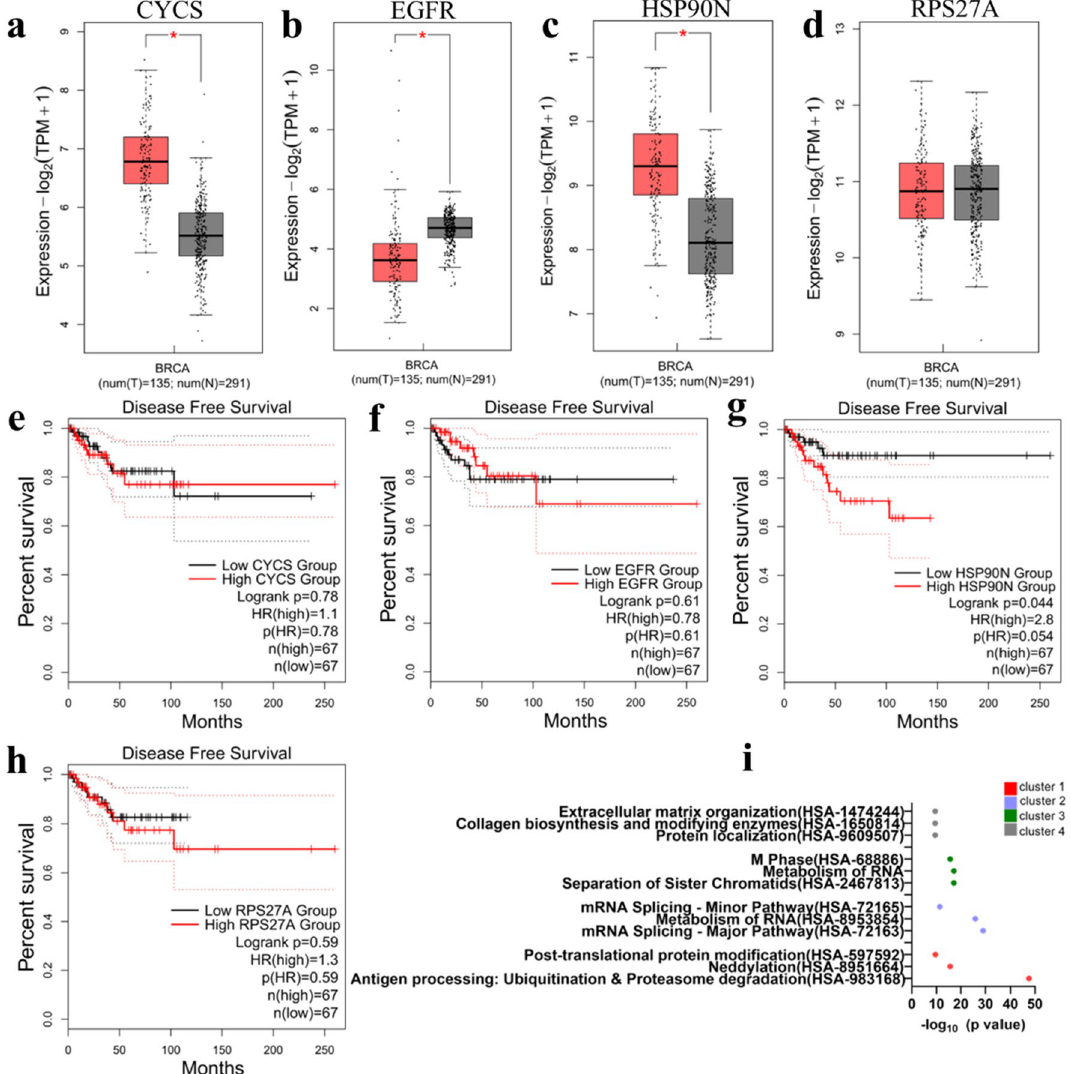
tissue respectively (significance < 0.05). ( e – h ) Disease-free survival plots of CYCS, EGFR, HSP90N and RPS27A respectively. ( i ) Reactome enrichment of the clusters of upregulated genes shows four highest clusters recognized (cluster